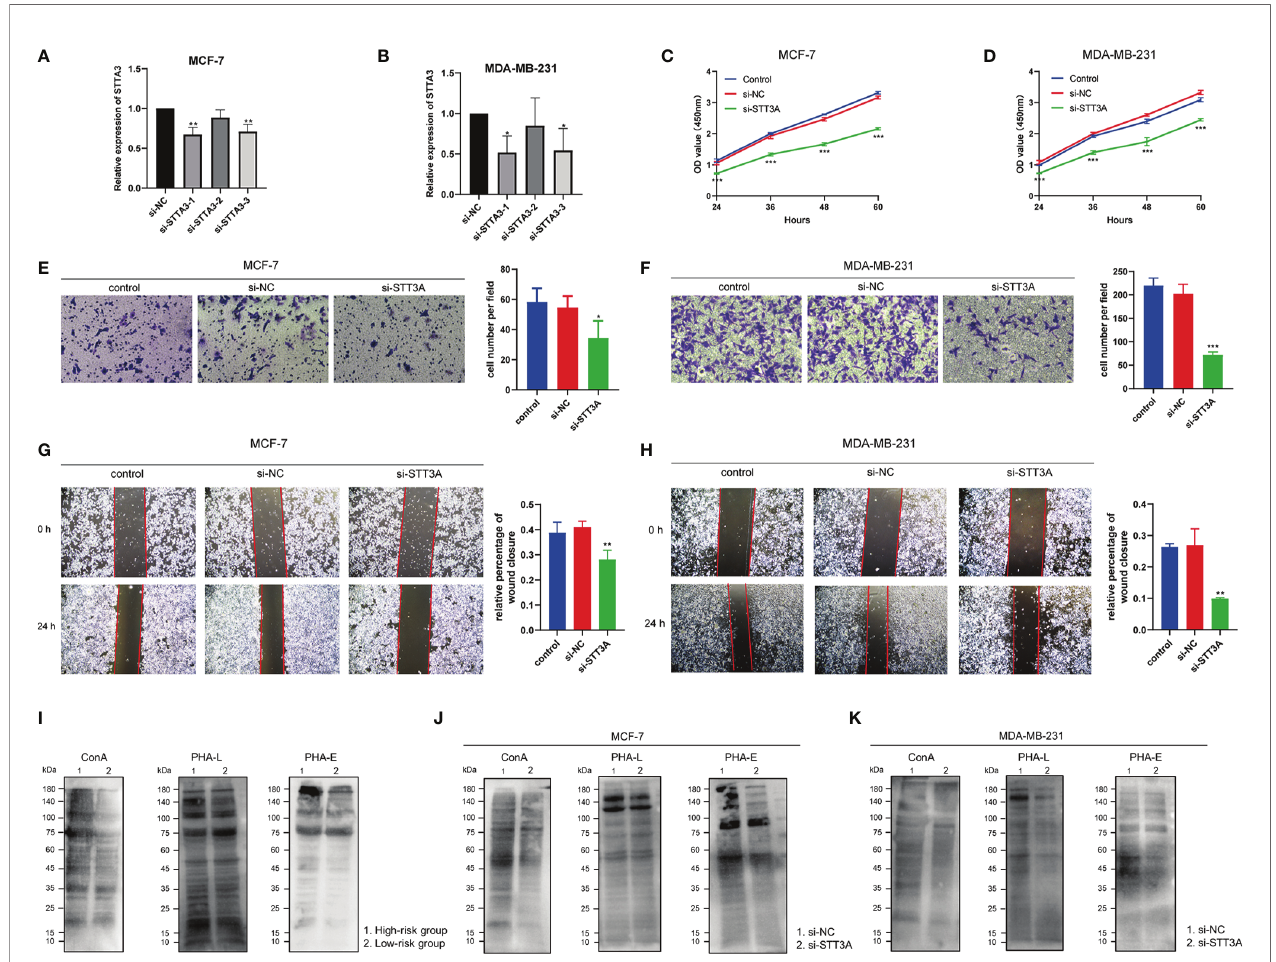
FIGURE 12 | STT3A regulated the proliferation and migration of BC cells. STT3A expression level of MCF-7 (A) and MDA-MB-231 (B) after silencing. CCK-8 assays were adopted to evaluate the proliferation ability of MCF-7 (C) and MDA-MB-231 (D) after silencing STT3A. Transwell assay (E, F) and wound healing (H, I) were performed to evaluate the migration ability of MCF-7 and MDA-MB-231 cells after silencing STT3A. Lectin blots with ConA, PHA-L, and PHA-E were performed in clinical samples in 2 risk groups (J) and MCF-7 and MDA-MB-231 cells after silencing STT3A (K, L) . BC, breast cancer; CCK-8, cell counting kit-8; ConA, concanavalin A; PHA-L, Phaseolus vulgaris leucoagglutinin; PHA-E, Phaseolus vulgaris